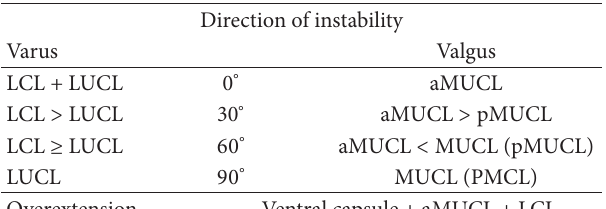
Table 1: Classification of elbow instability and labeling of injured ligaments.